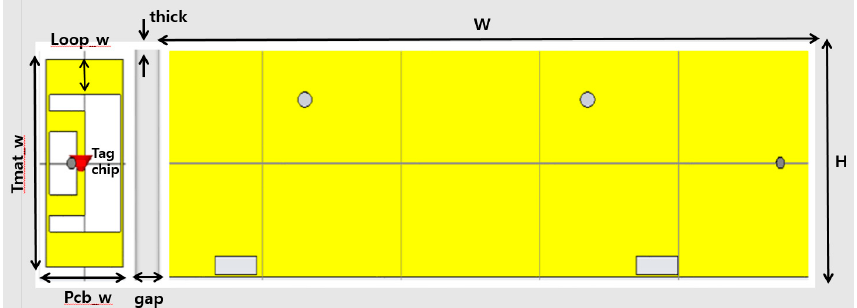
Figure 3. License plate tag antenna attached next to the plate holder facing bumper side.